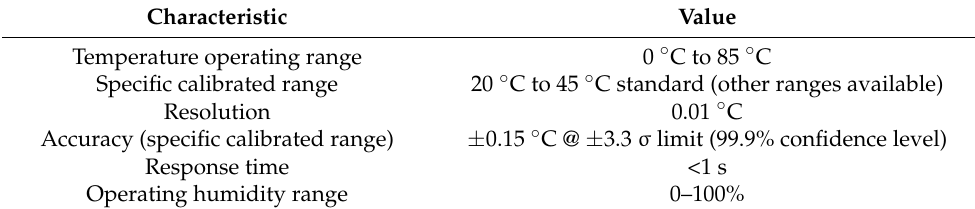
Table 1. Characteristics of the AccuSens interferometric signal conditioner.